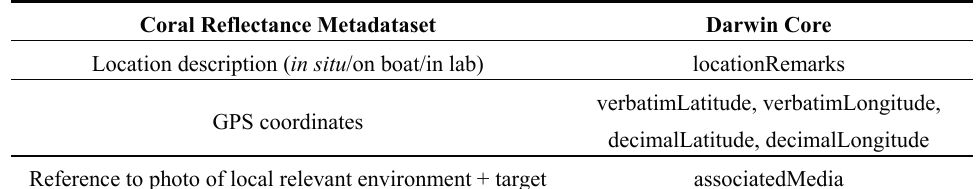
Table A10. Mappings from Darwin Core to the underwater benthic reflectance